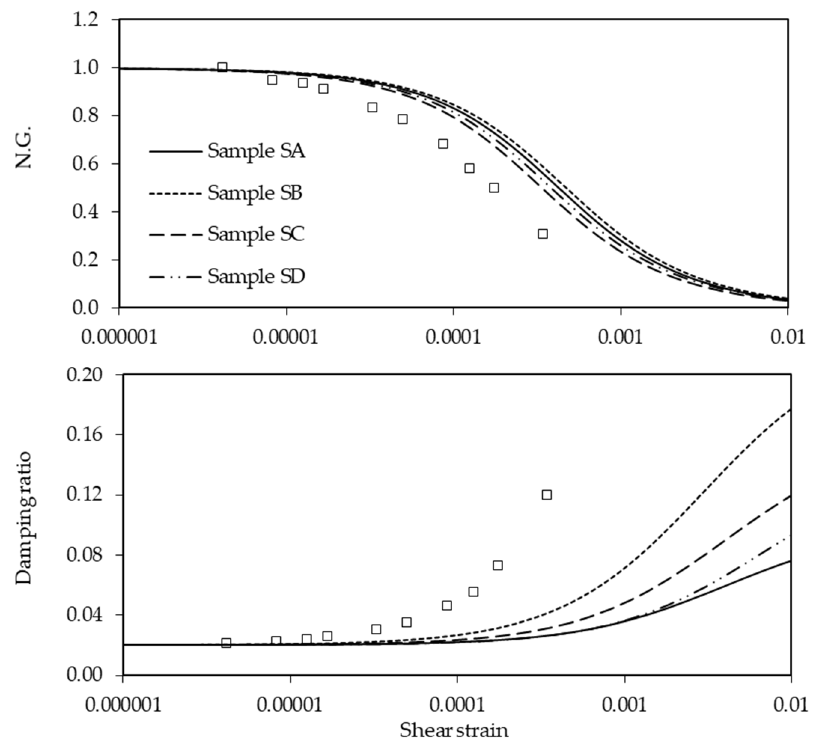
Figure 8. Comparison of proposed degradation models from the study by Jafarian et al. [9] on cal ‐ careous sand at Confinement ( σ ) = 40 kPa from resonant column (RC) testing.